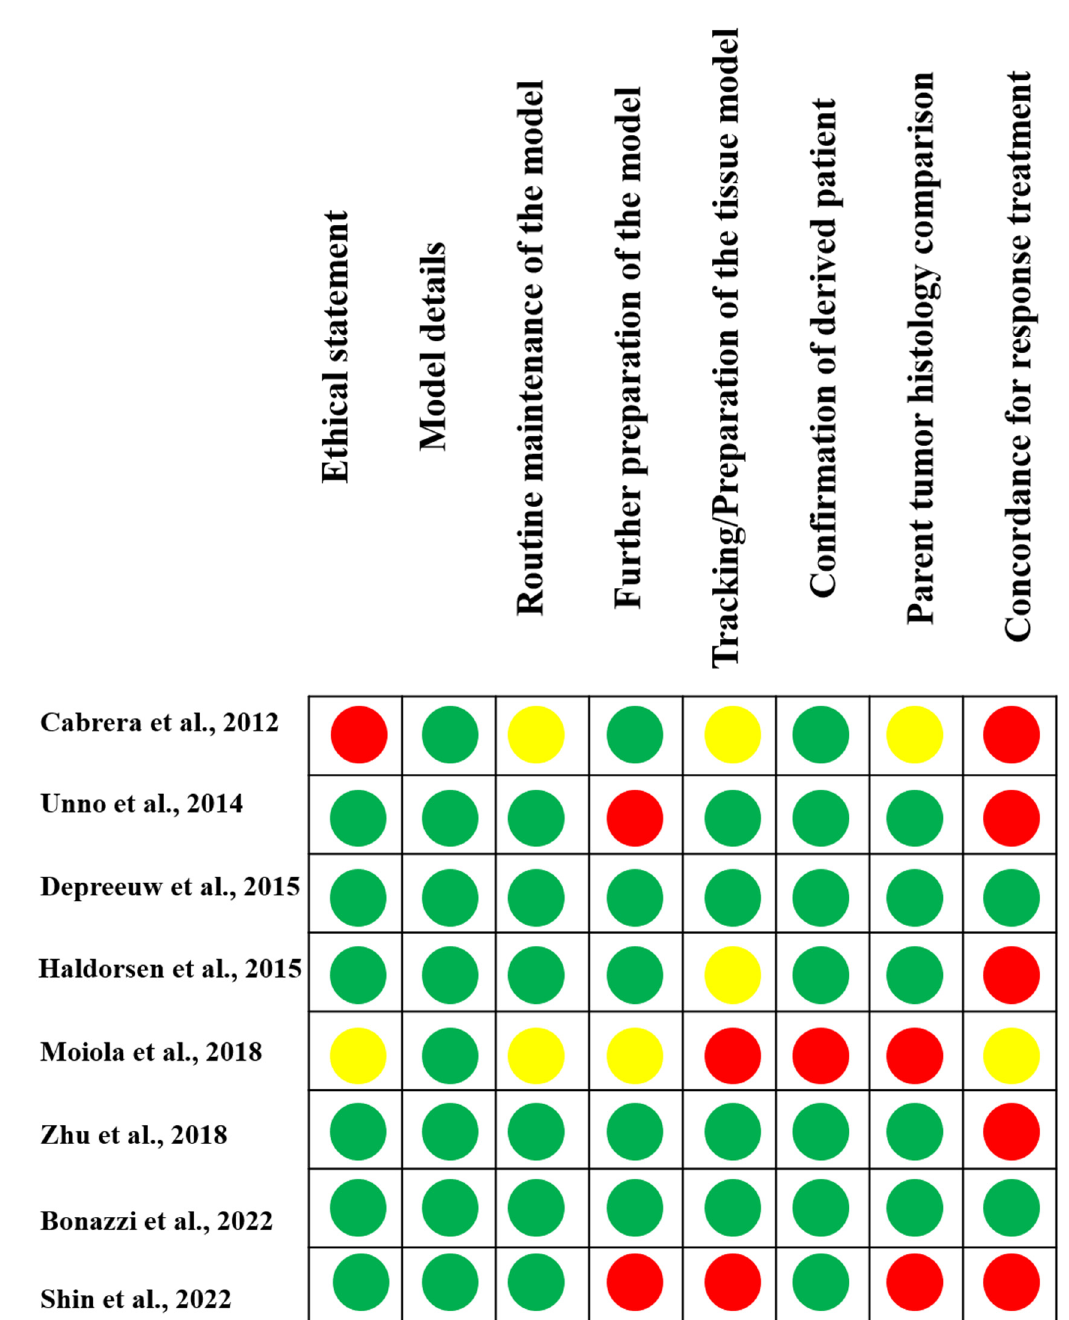
Figure 3. Quality assessment of the studies included in this systematic review. Green circles indicate studies that reported the evaluated item (low risk of bias); red circles indicate studies that did not report the evaluated item (high risk of bias); and yellow circles indicate studies that did not define or only partially reported the evaluated item [8–15].